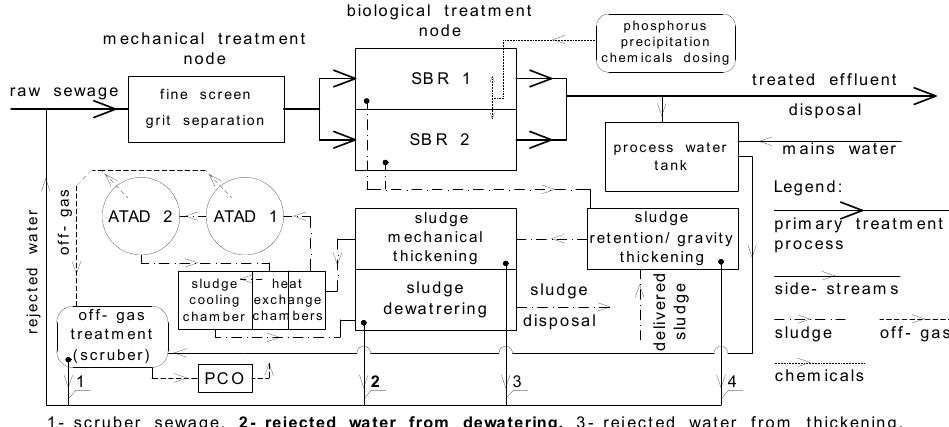
Figure 2. Simplified process flow diagram of WWTP2.